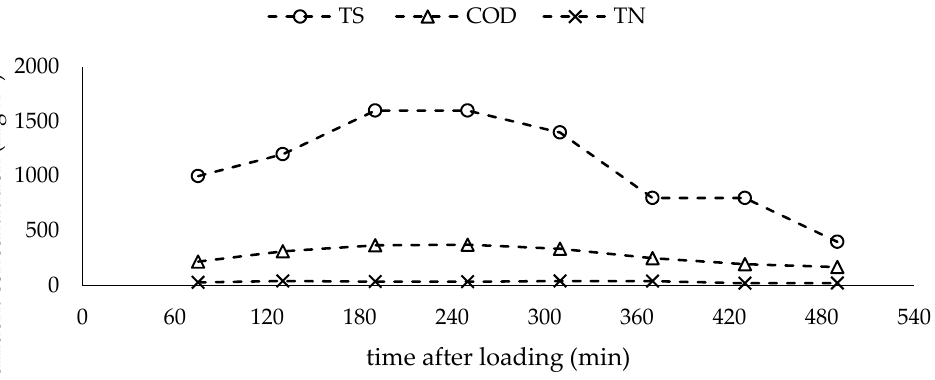
Figure 4. The dynamics of TS concentration (influent = 4600 mgL − 1 ), COD concentration (influent = 4203 mgL − 1 ) and TN concentration (influent = 150 mgL − 1 ) obtained from case 100B in Phase II of the experiment. The concentrations of these contaminants dropped substantially in the early discharge due to the physical filtration.